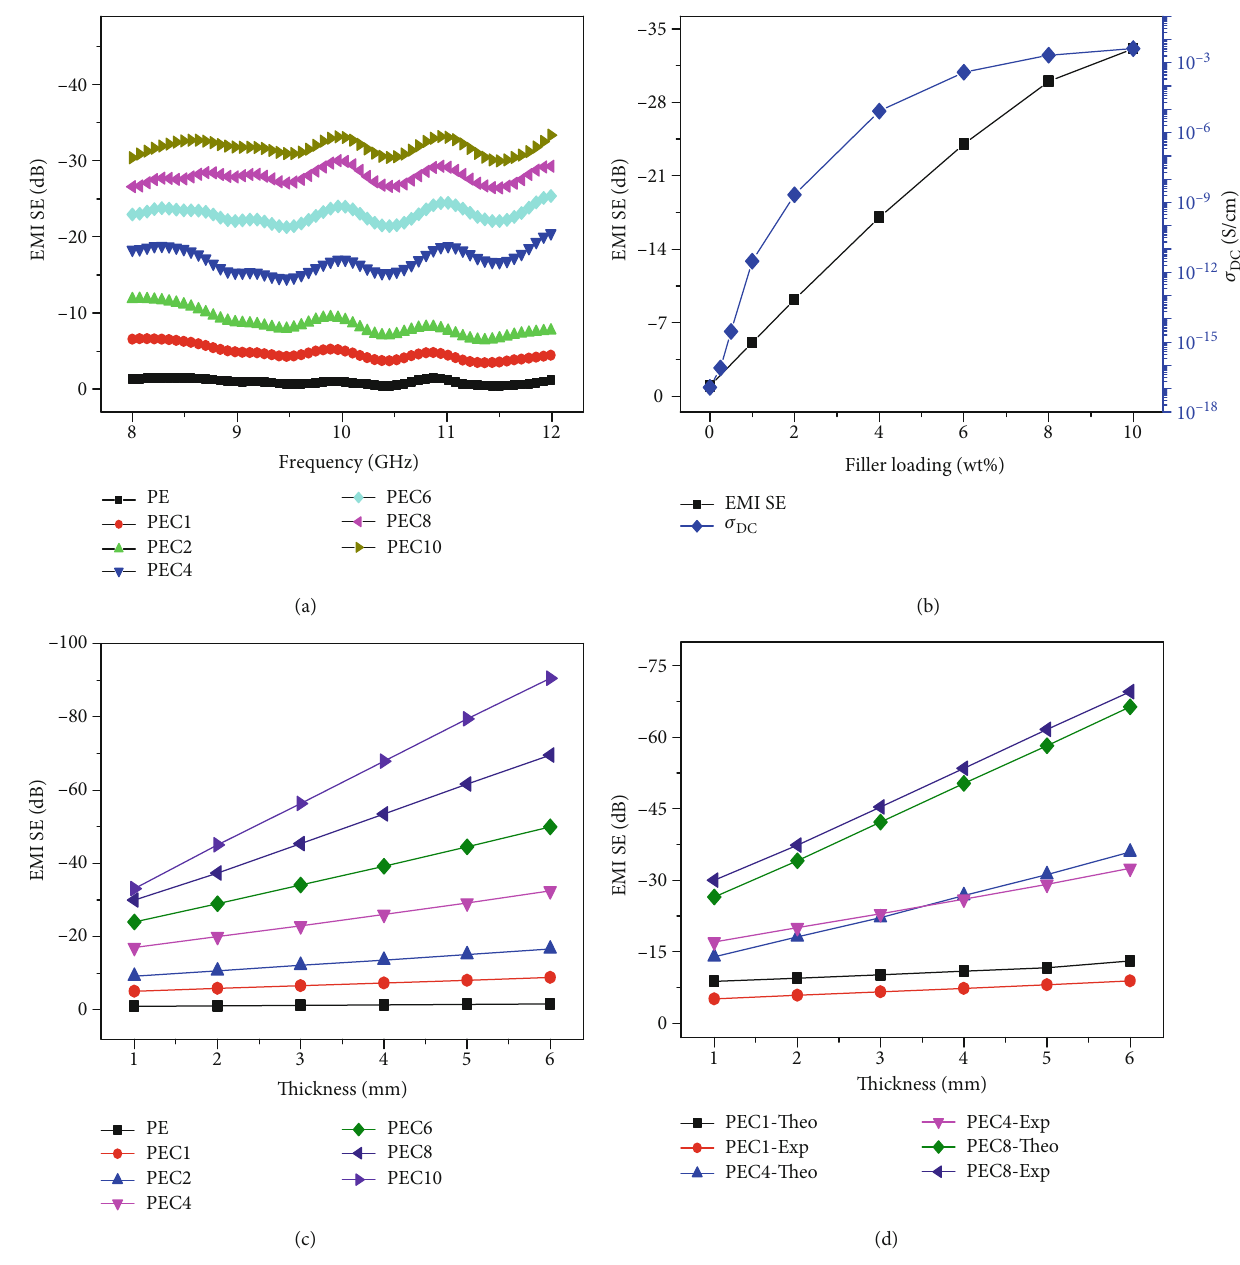
Figure 12: (a) Variation of EMI SE with respect to frequency, (b) comparison of the variation trend of EMI SE and conductivity with respect to fi ller loading, (c) variation of EMI SE with respect to sample thickness, and (d) theoretical and experimental EMI SE with respect to sample